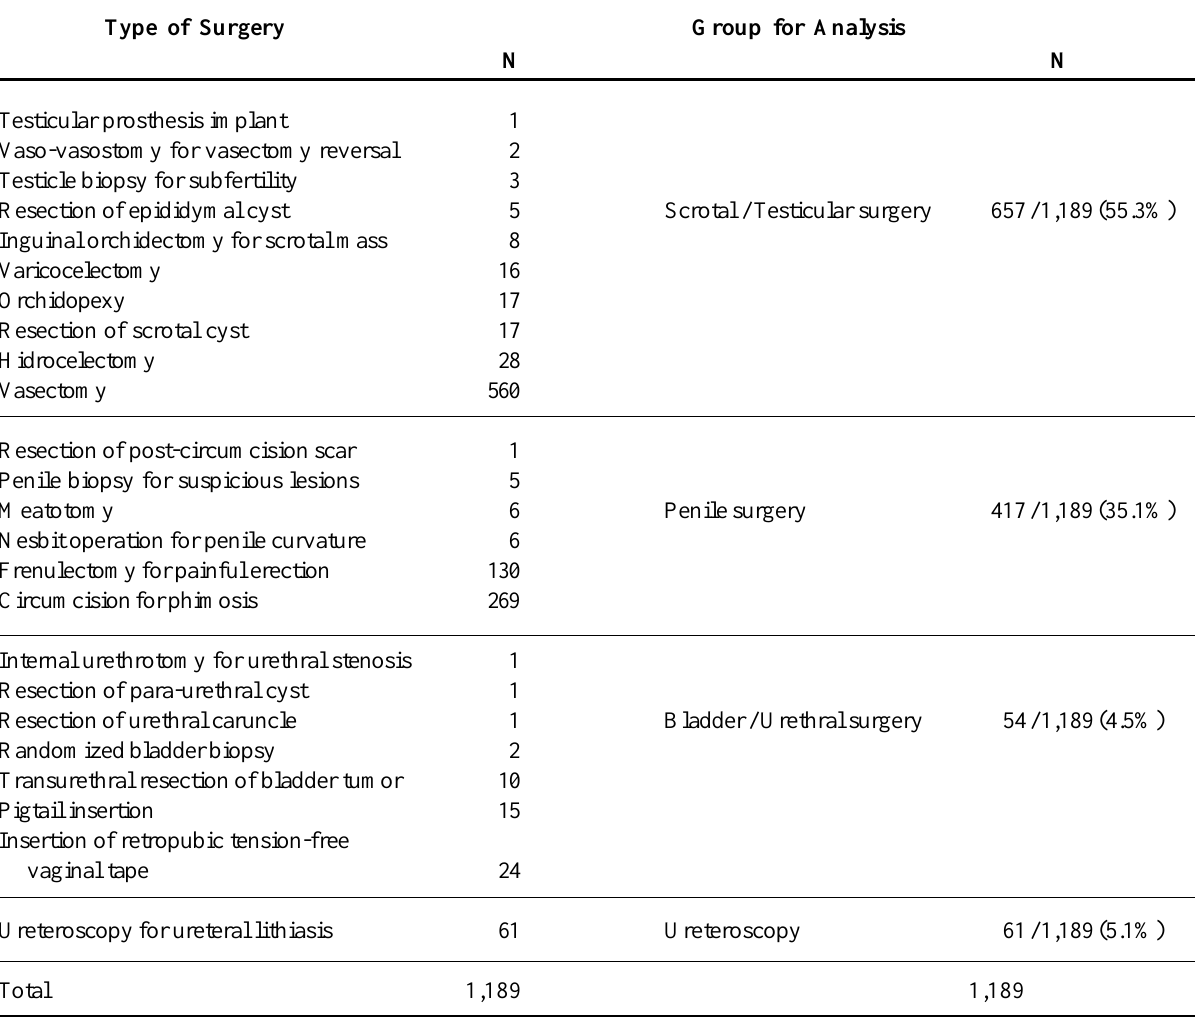
Table 1 – Type of surgery and groups for mathematical analysis. Twenty-one different types of surgery were classified into 4 major